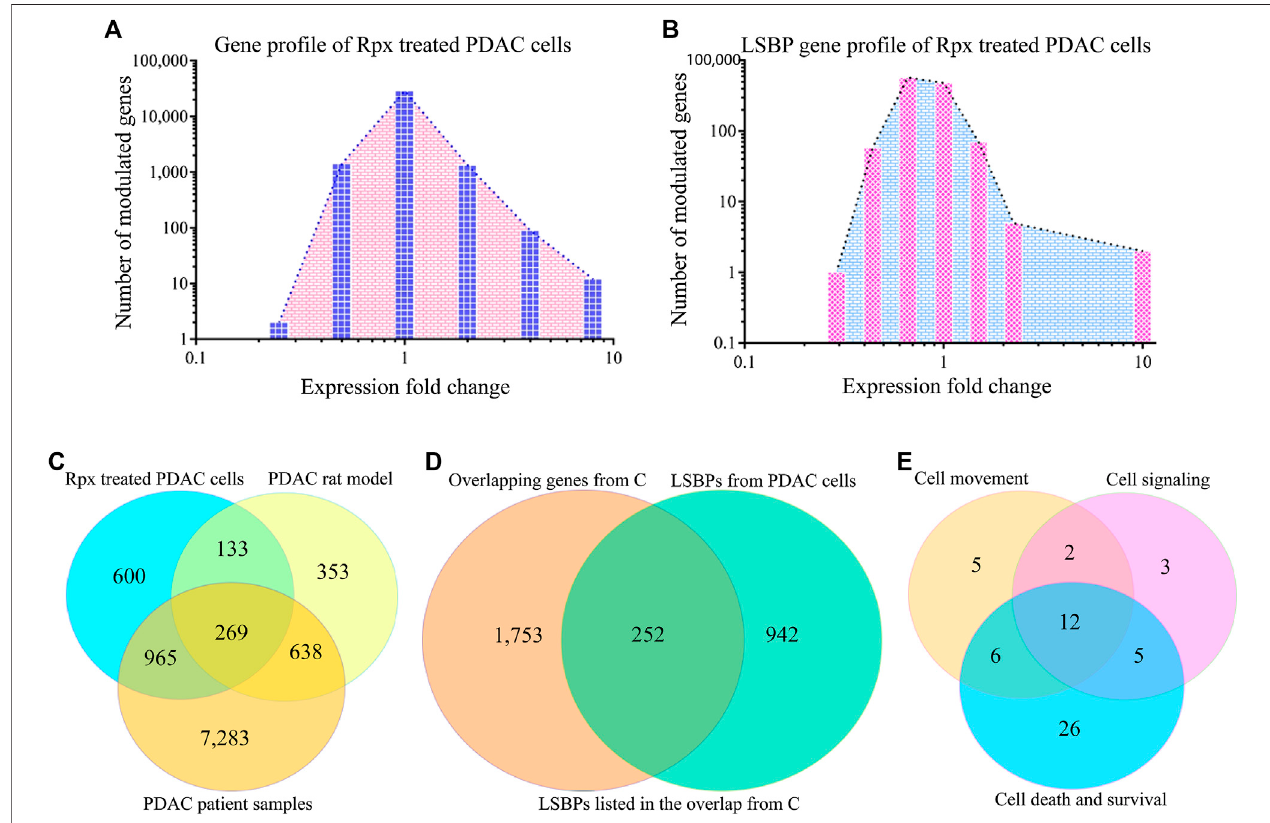
FIGURE 5 | Analysis of riproximin-induced changes in gene expression. (A) Represents the mRNA expression of Suit2-007 cells following Rpx treatment at 48 h. (B) Shows the mRNA expression for the subgroup of LSBP genes, which were extracted from the data shown in (A) . (C) Represents a Venn diagram analysis for all modulated genes ( n (cid:2) 15,257) from the three matching data sets, i.e., from Rpx-treated Suit2-007 cells, the PDAC rat model and PDAC patient samples. (D) Is a Venn diagram analysis for genes listed in at least two or more data sets, as shown in (C) : These genes ( n (cid:2) 2,481) were related to all identi fi ed LSBPs ( n (cid:2) 1,194). (E) Represents a Venn diagram analysis for 68ofthe 269 LSBP genesshown in (D) ,which wereobtained following IPA evaluation. The analysis focused on three functional annotations, viz “ cell movement ” , “ cell signaling ” and “ cell death and survival ” .